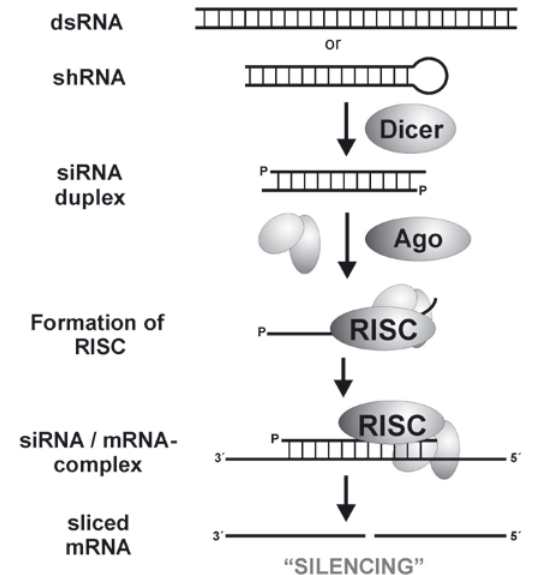
Figure 1. Mechanisms of RNA